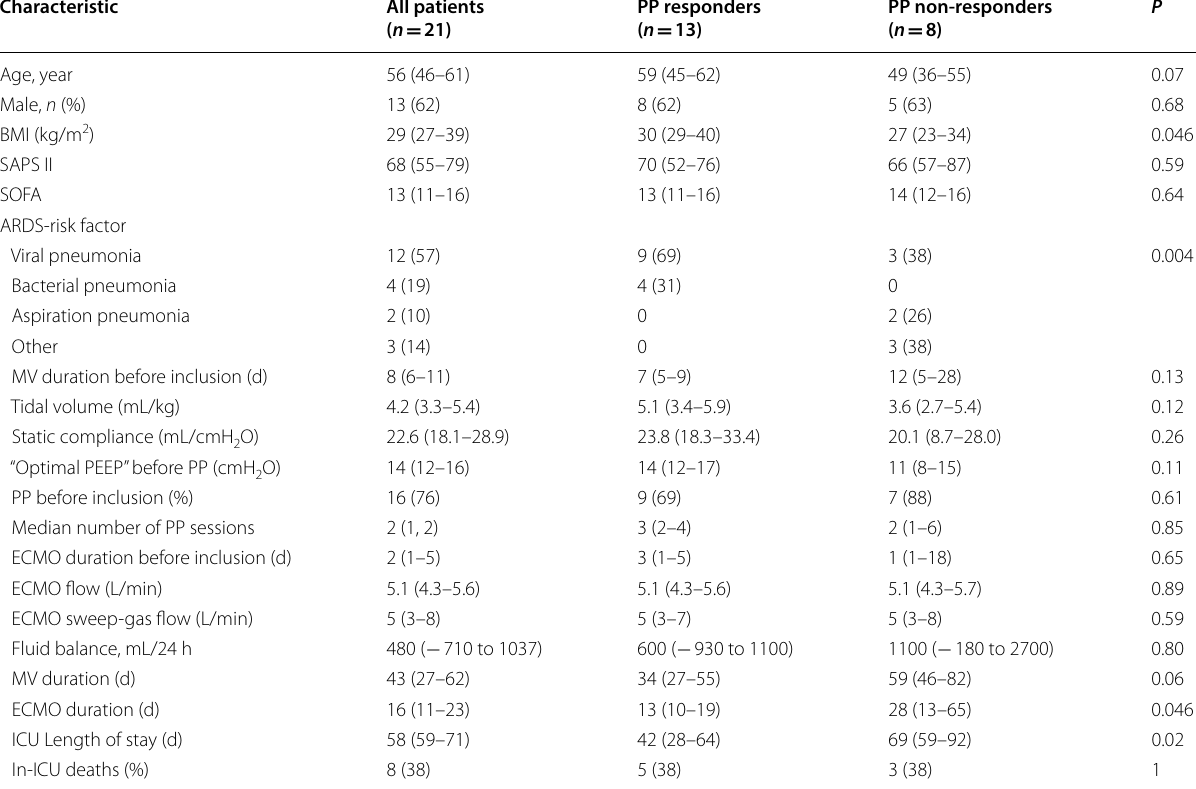
Table 1 Characteristics and outcomes according to PP-responder